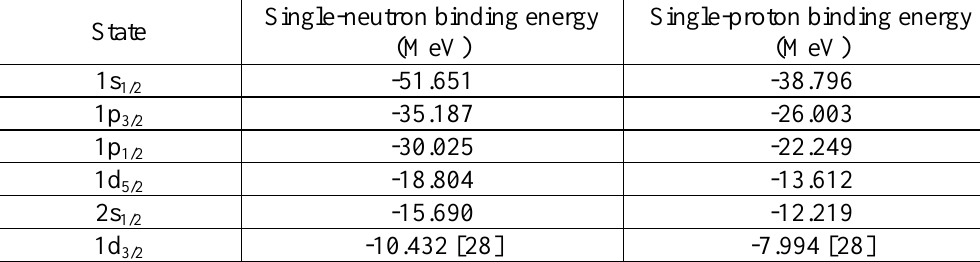
Table 5: Single-nucleon binding energies for 19 F.